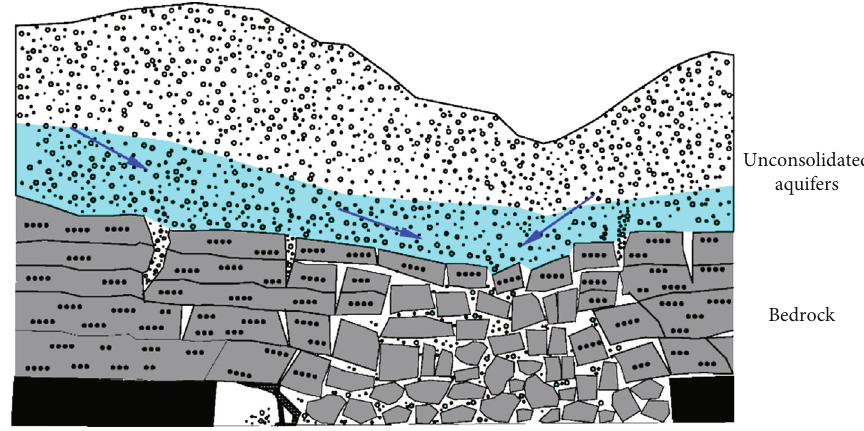
Figure 1: Schematic diagram of water and sand inrush through caved